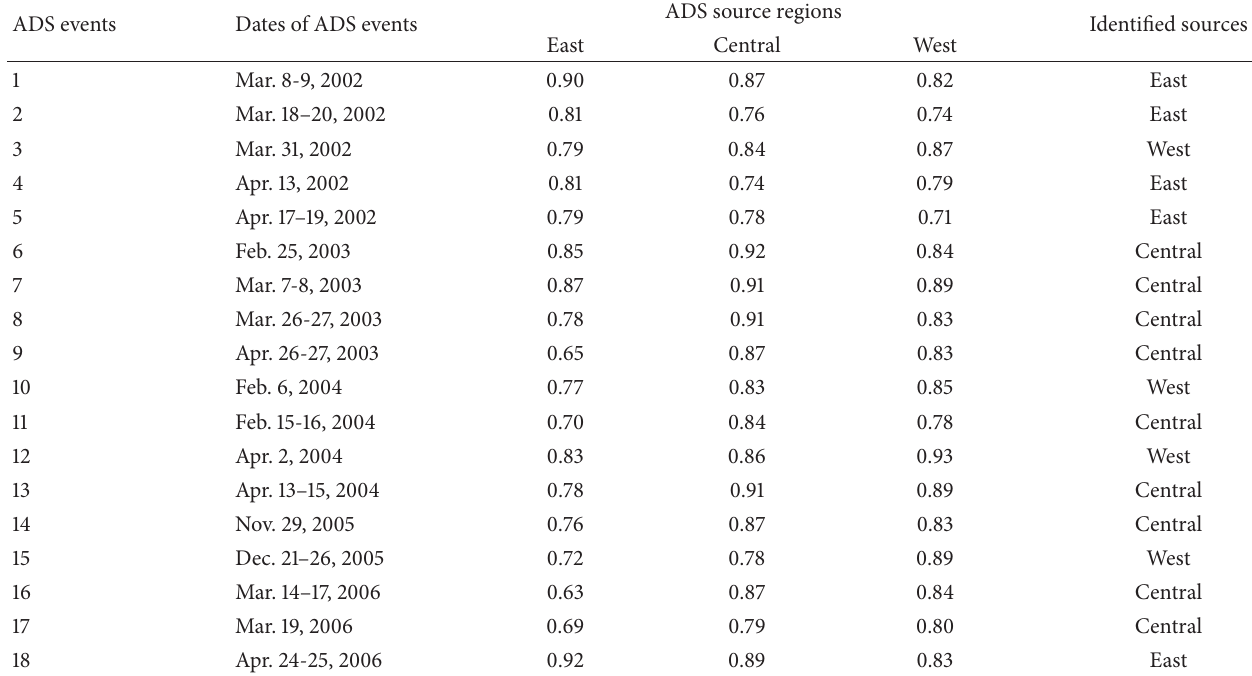
Table 3: Source allocation of 18 ADS events in the Inner Mongolia by grey relational